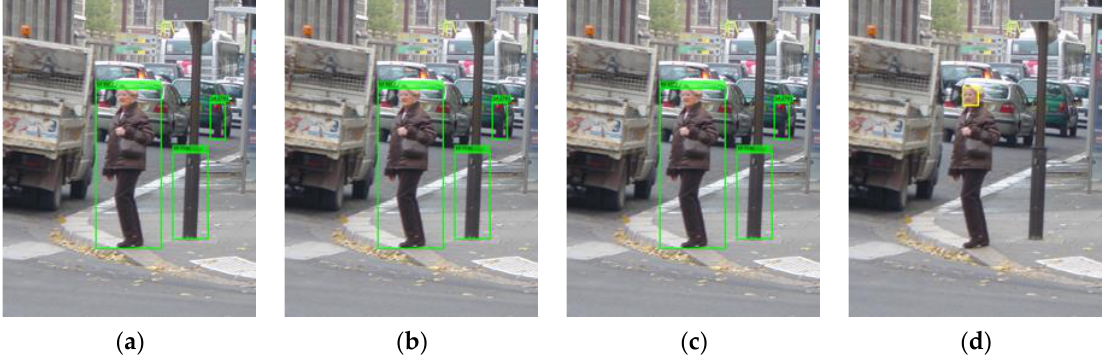
Figure 9. Detection results of the ACF detector ( a ), the integrated detector with 𝑜𝑓𝑓𝑠𝑒𝑡 = 0 ( b ) ⁡and⁡𝑜𝑓𝑓𝑠𝑒𝑡 = 5 ( c ), and the MTCNN detector ( d ).